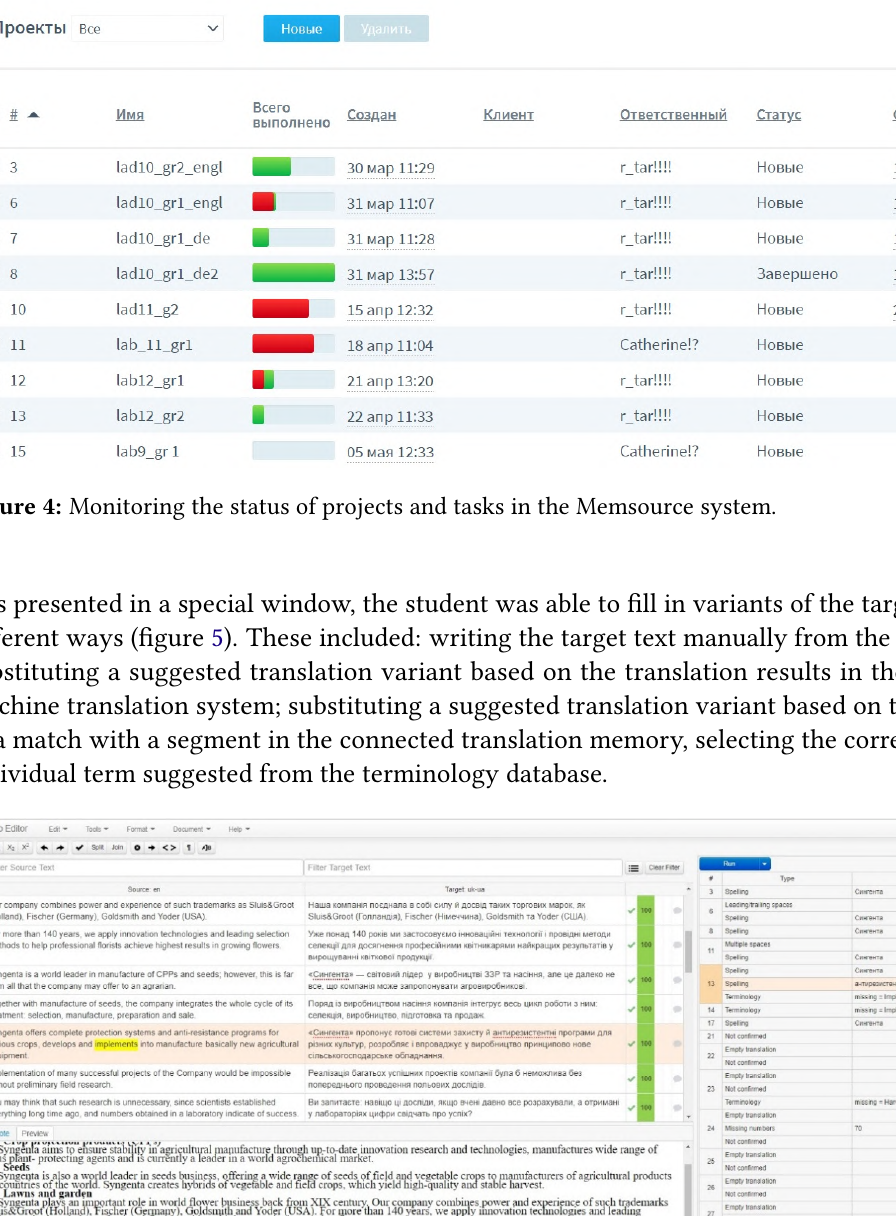
Figure 5: Example of translation in the Memsource system.